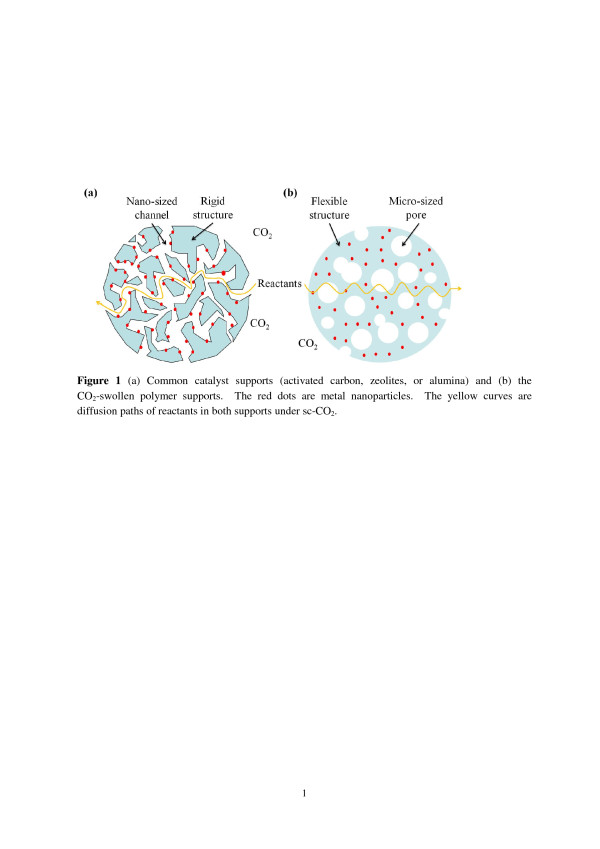
The micrometer-sized catalyst supports and CO2-swollen centimeter-sized polymer supports. (a) Common micrometer-sized catalyst supports (activated carbon, zeolites, or alumina) and (b) the CO2-swollen centimeter-sized polymer supports. The red dots are metal nanoparticles. The yellow curves are diffusion paths of reactants in both supports under sc-CO2.